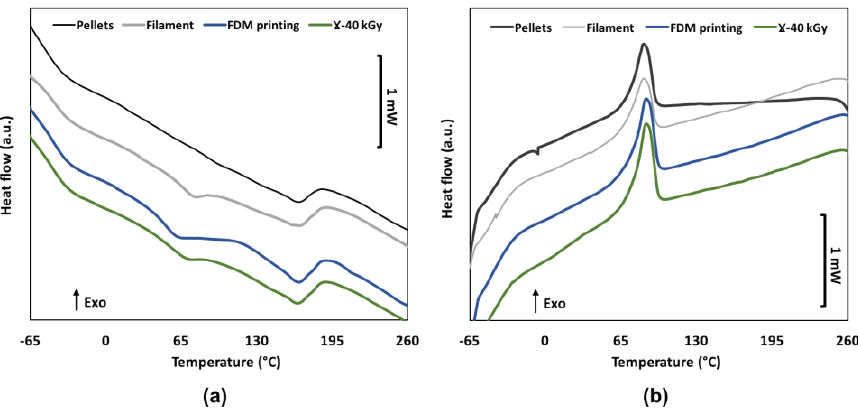
Figure 2. Impact of the manufacturing process on Mw ( a ); Mn ( b ); and Ip ( c ). Data are expressed as mean ± SD (n = 6), * p < 0.05 (between each processing step, Student t -test).